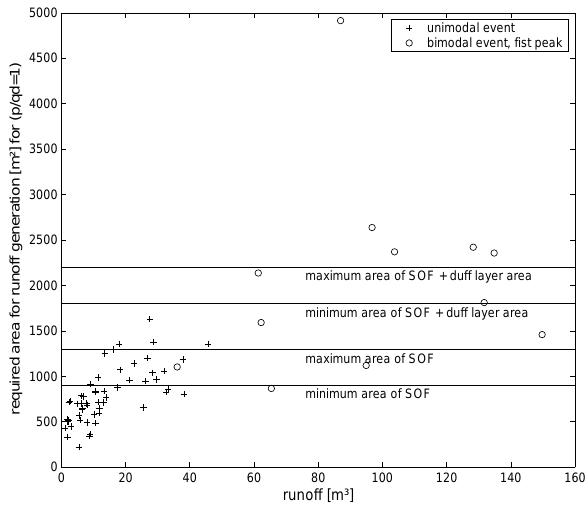
Fig. 7. Required area to generate the observed runoff volume of the first peak of bimodal events and of the unimodal events, under the assumption that the event runoff coefficient equals 1 (SOF: satura- tion area).